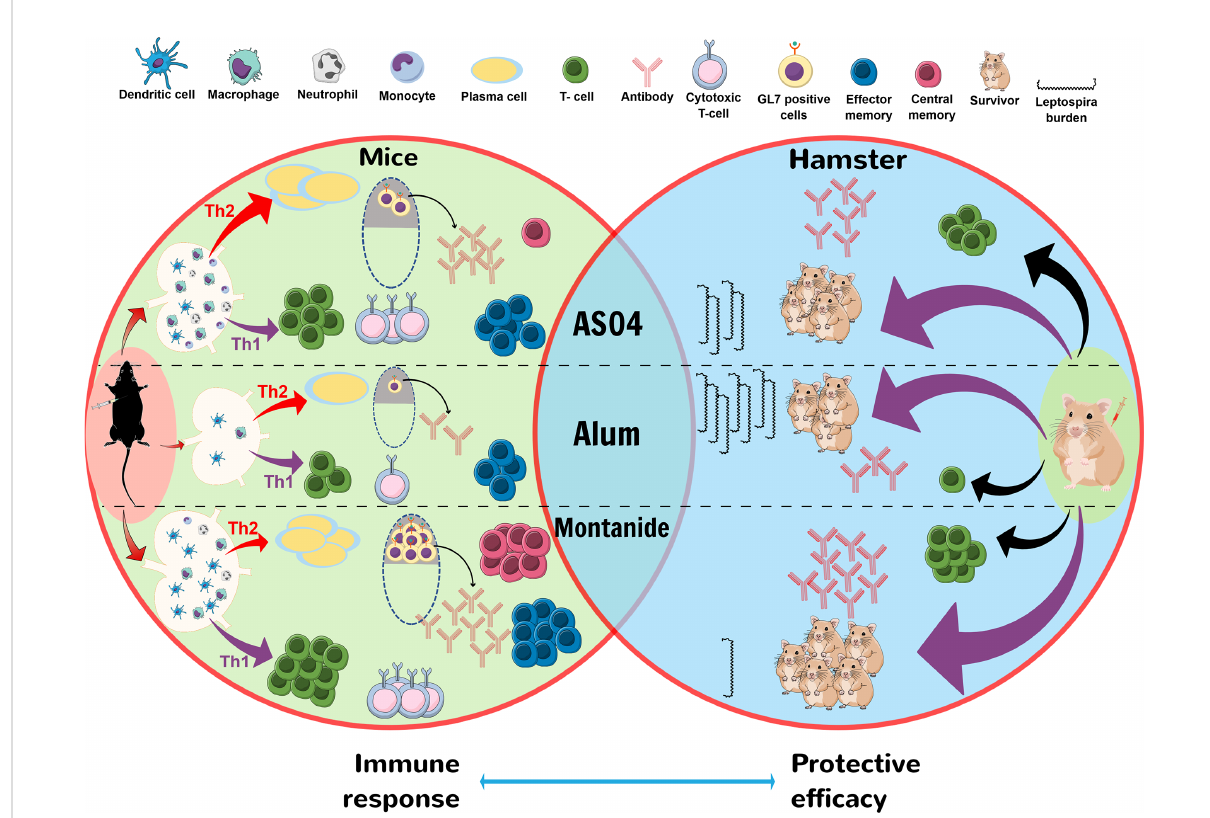
FIGURE 6 Schematic presentation of mechanism by which LAV-AS04 or LAV-M induces superior immune response and protective ef fi cacy than LAV-Alum in mice and hamster model. Mice immunized with LAV-Alum were able to recruit few innate immune cells at DLNs leading to induction of low level of B cells (antibodies), T cells (mainly Th2 cells), low GC reaction, and limited immunological memory (low numbers of effector memory cells). In contrast, LAV-AS04 recruited a signi fi cantly higher number of innate immune cells leading to induction of enhanced level of antibodies and T cells (both Th1 and Th2 cells) and also generation of both effector and central memory T cells. LAV-M recruited a much higher number of innate immune cells correlating to higher level of antibodies and T cells than LAV-AS04, along with enhanced GC reaction and generation strong memory response. Hamsters immunized with LAV-M and LAV-AS04 generated signi fi cantly higher levels of antibodies and T cells than LAV-Alum. These antibodies and T cells were protective and were able to kill the Leptospira leading to reduced bacterial load in